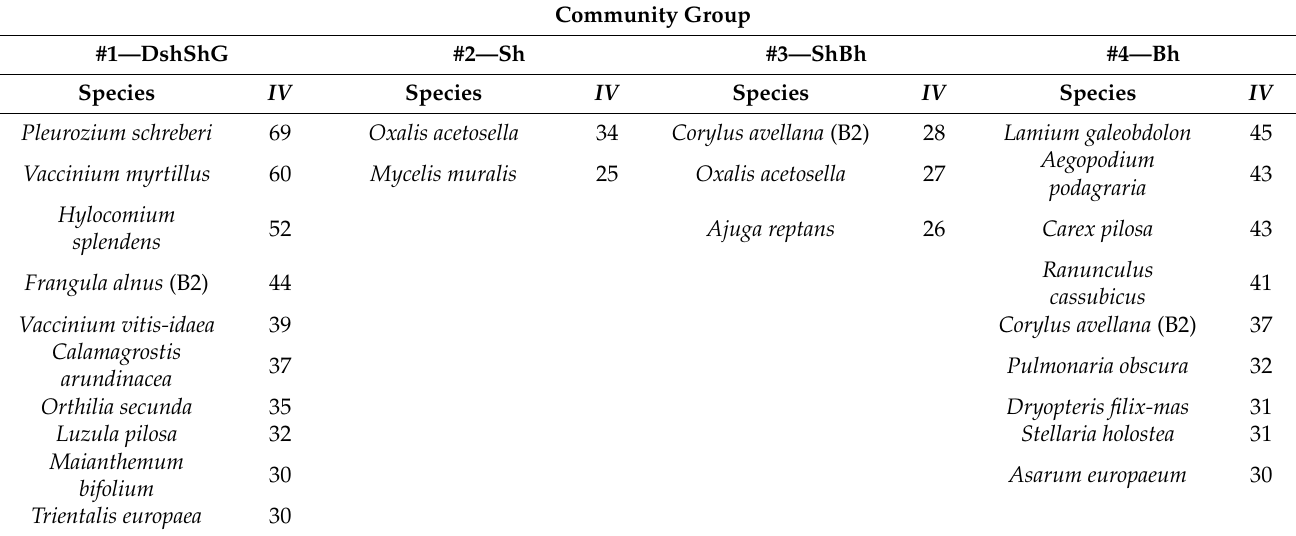
Table A2. Indicator values (IV) for species in community groups of spruce and spruce–small-leaved forests. Community